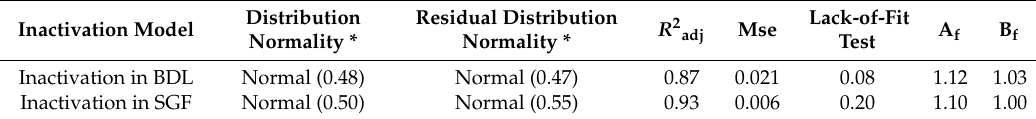
Table 3. Distribution normality and performance of S . Typhimurium inactivation indices in the BDL matrix followed by SGF